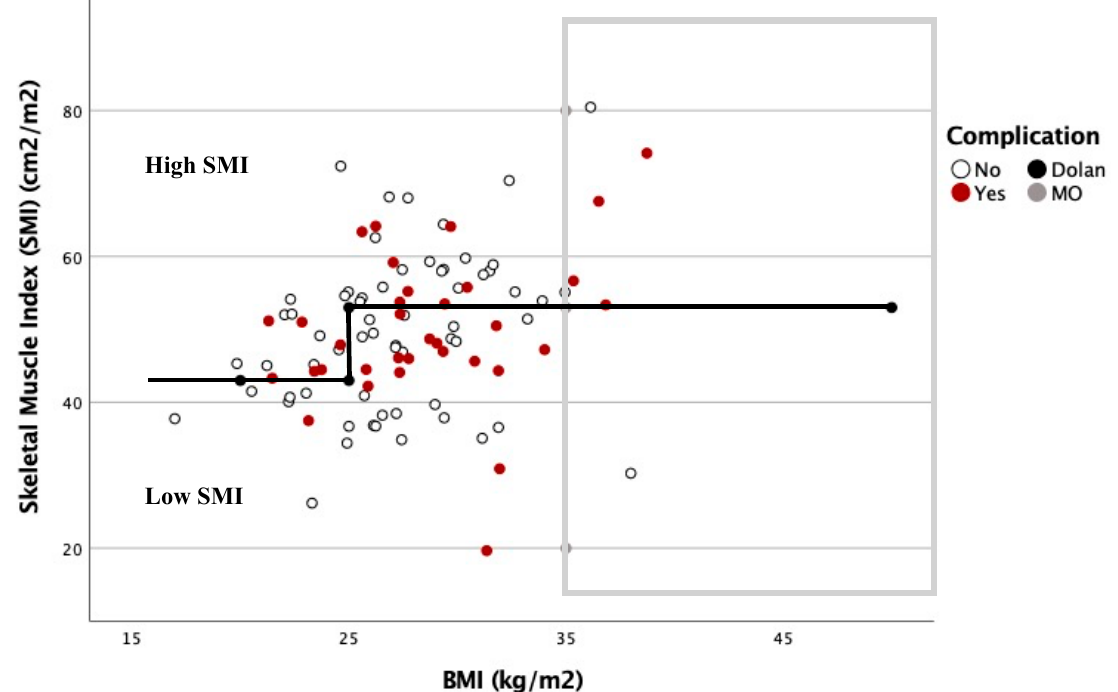
Figure 3. Dispersion diagram correlating complications between BMI and SMI in men.